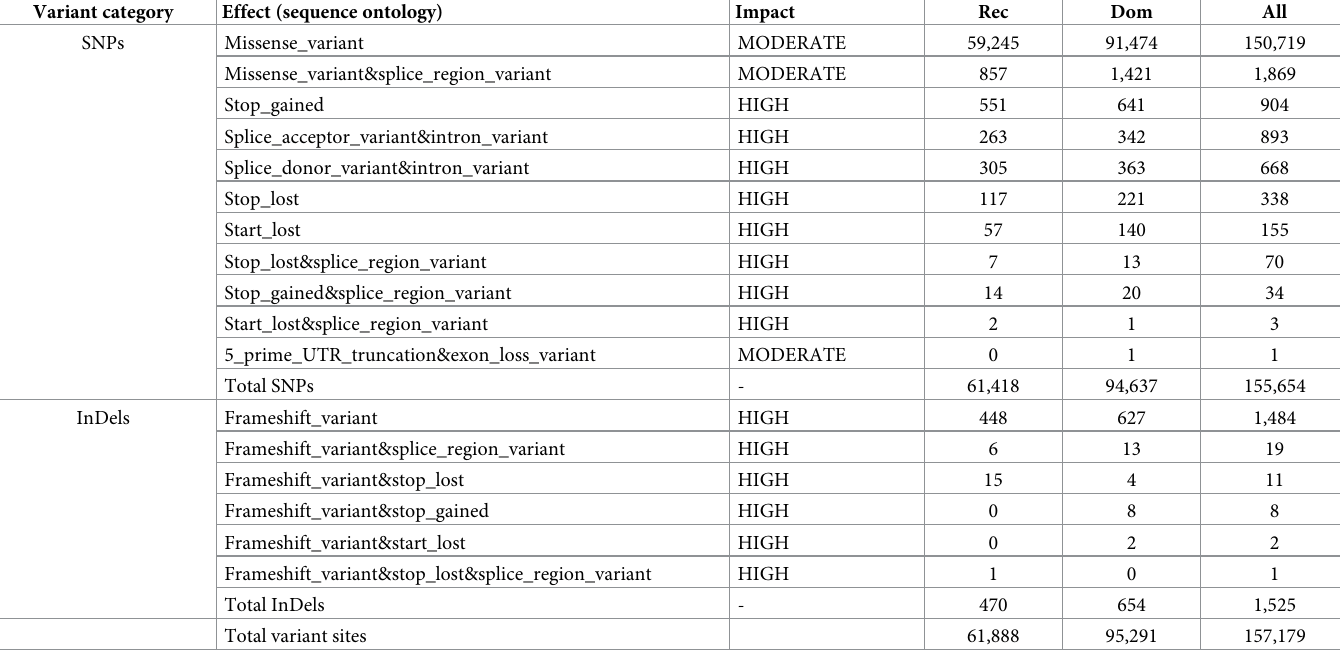
Table 2. Summary of variant calling between Rec and Dom. Variant